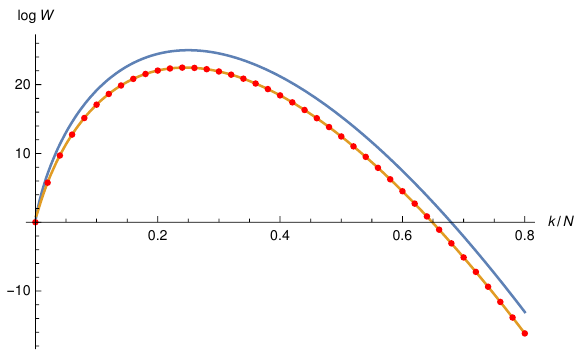
Figure 10. Plot of log W S in the ungapped phase ( g = 0 : 5 ; N = 100). The red dots are k the exact values, while the blue curve and the orange curve represent the leading term and the leading+one-loop correction in (6.13), respectively. Again, one can see that the inclusion of the one-loop correction improves the